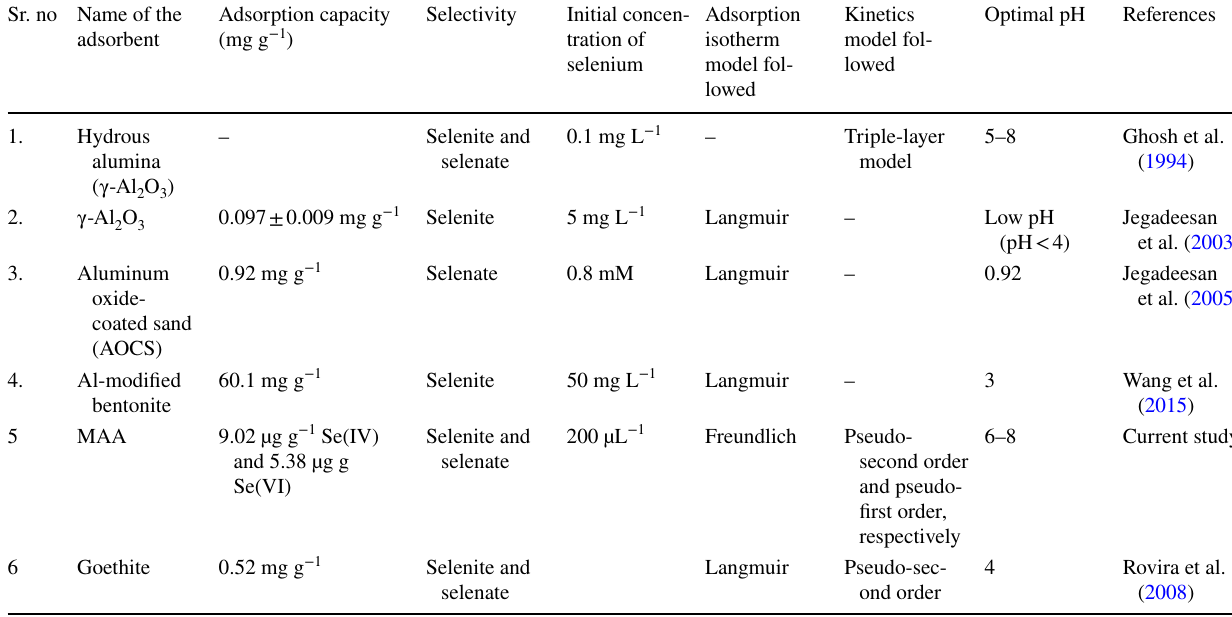
Table 4 Comparison of the MAA with other adsorbents Sr. no Name of the